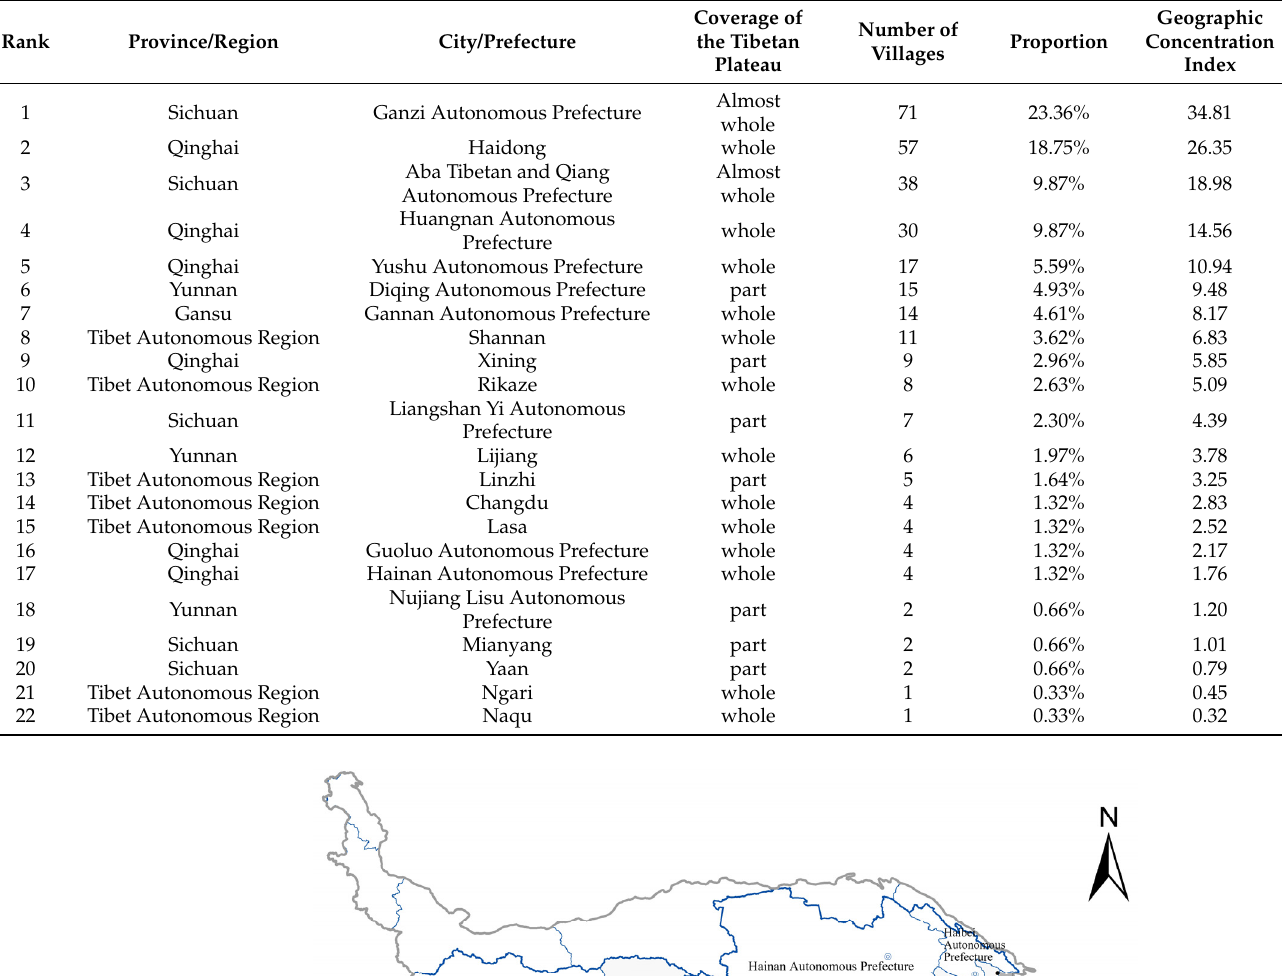
Table 4. Statistics related to traditional villages at the city level on the Tibetan Plateau.